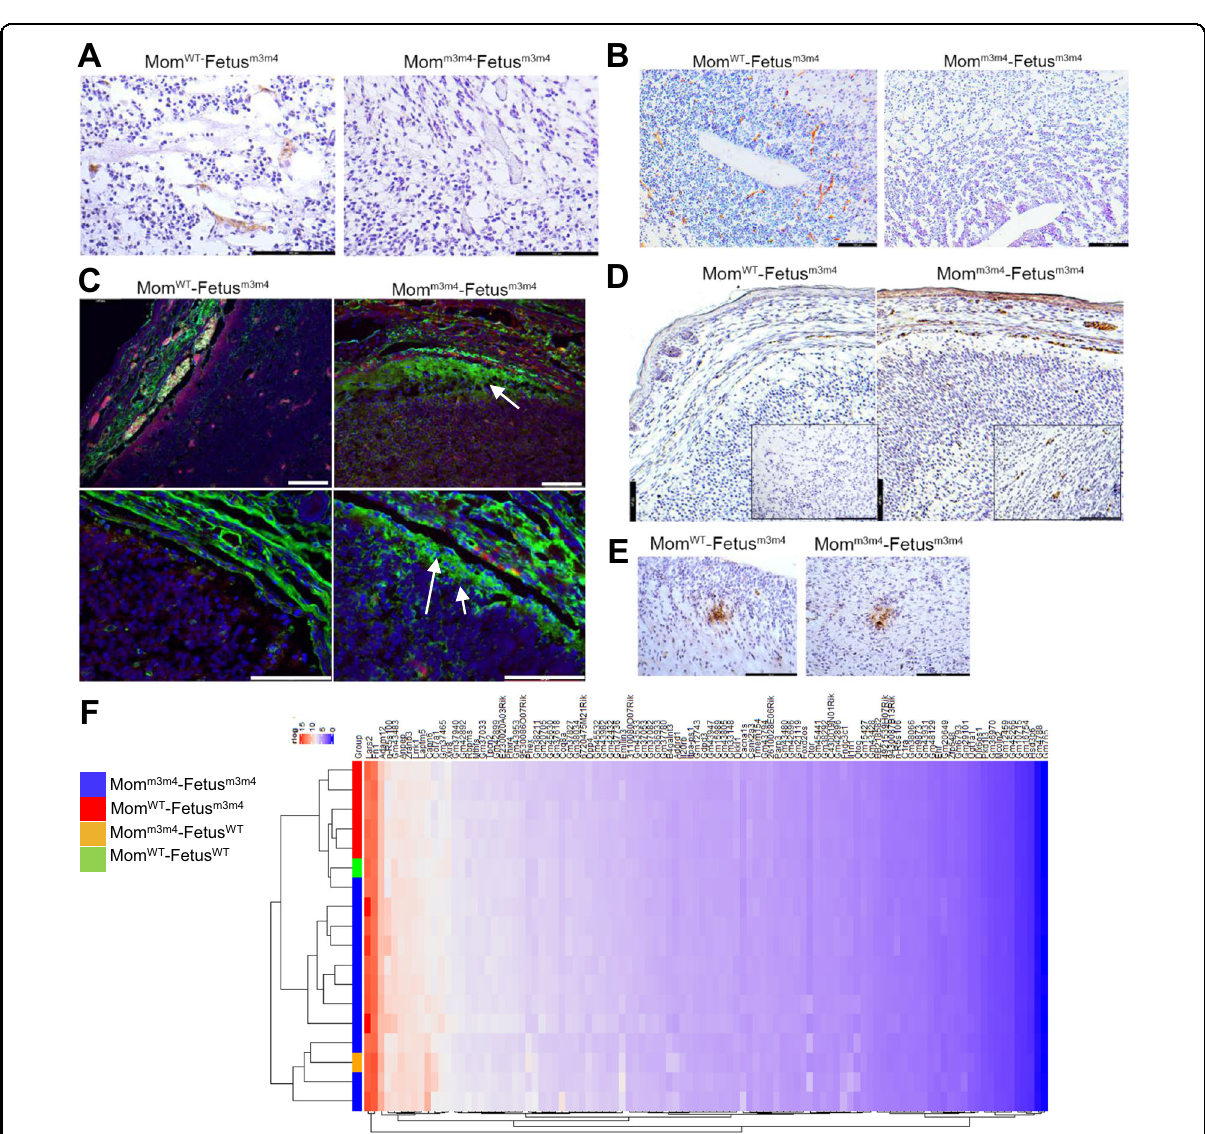
Fig. 3 Breakdown of the blood – brain – barrier in fetuses undergoing gestation in Mom m3m4 . IHC for A Glut-1 (representative of n = 4 mice/ group) and B CD31 (representative of n = 4 mice/group) BBB markers in fetuses from Mom m3m4 and Mom WT . C IF staining for albumin (representative of n = 6 mice/group). Arrows show albumin leakage into the brain parenchyma and perivascular areas. Lower panels show higher magni fi cation images. D IHC for complement protein C4 (representative of n = 6 mice/group) in blood vessels and brain parenchyma (shown in high magni fi cation inserts). E IHC for complement protein C3 in the brain of fetuses derived from either maternal genotype (representative of n = 2 mice/ group). Scale bars = 100 µm. F Heat map of fetal brain gene expression at E17.5 showing unsupervised differential clustering of Mom m3m4 fetuses (blue and orange) from Mom WT fetuses (red and